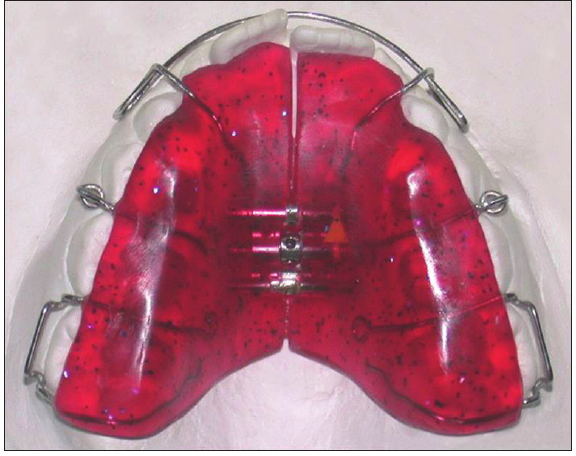
Figure 1. Modified slow maxillary expansion appliance